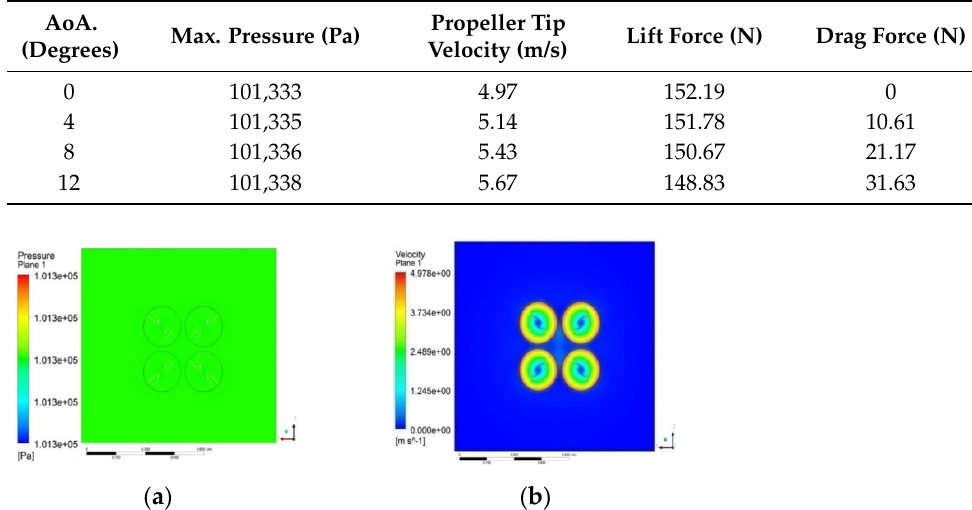
Figure 26. Hovering flight of UAV. ( a ) Pressure at 0° AoA, ( b ) Velocity at 0° AoA. Table 13. Lift and drag force for different AoA during hovering phase.